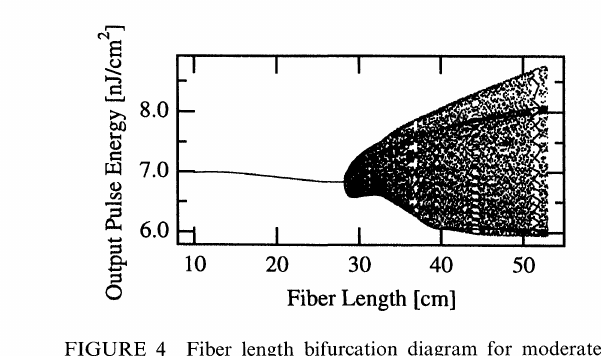
FIGURE 4 Fiber length bifurcation diagram for moderate fiber coupling (3’1 0.5 and 72 =0.6) showing a large unstable region.